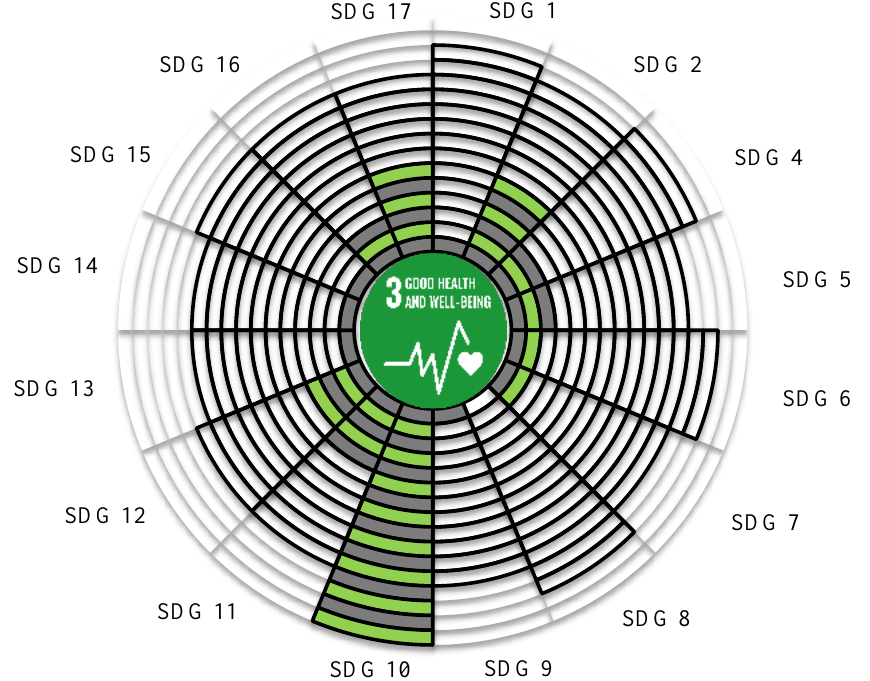
Figure 7. The comparison of academic (black frame) with communication (filled colored grids) industries on the tied frequency of SDG 3 and other SDGs in 2018.